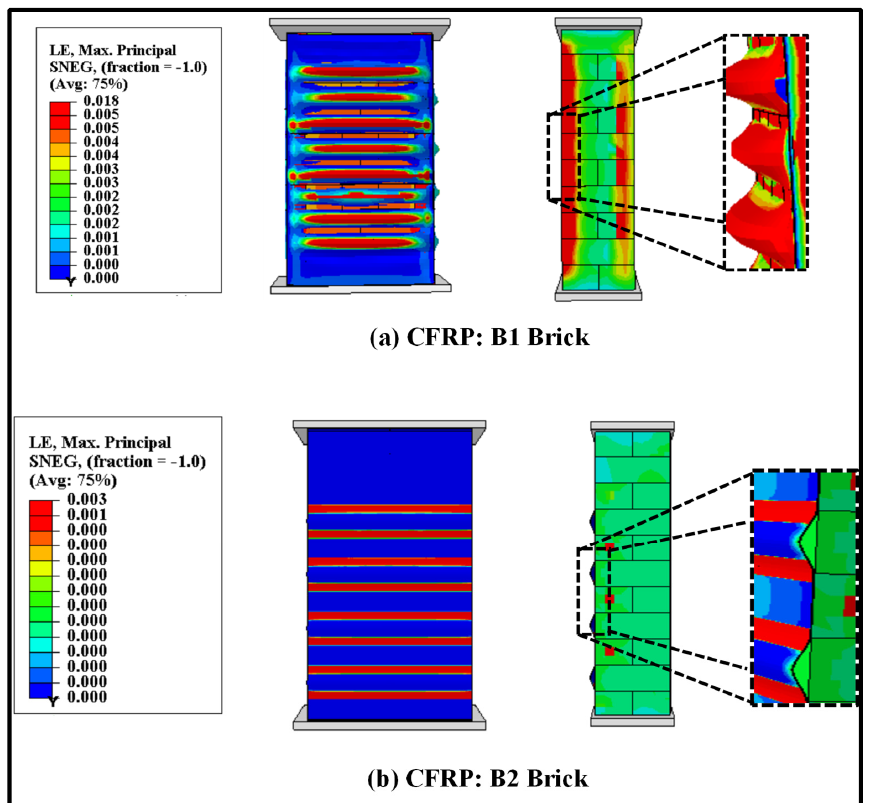
Figure 16. Numerically predicted damage on the surface of the CFRP fabric and masonry wallettes constructed of different brick types; ( a ) B1 and ( b ) B2 under cyclic loading.